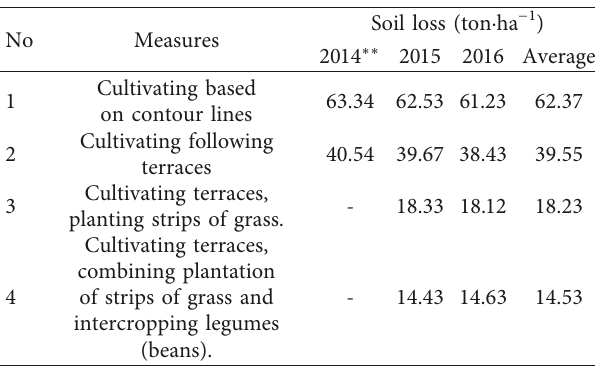
Table 6: Soil loss caused by different cultivation measures in Muong Bo.